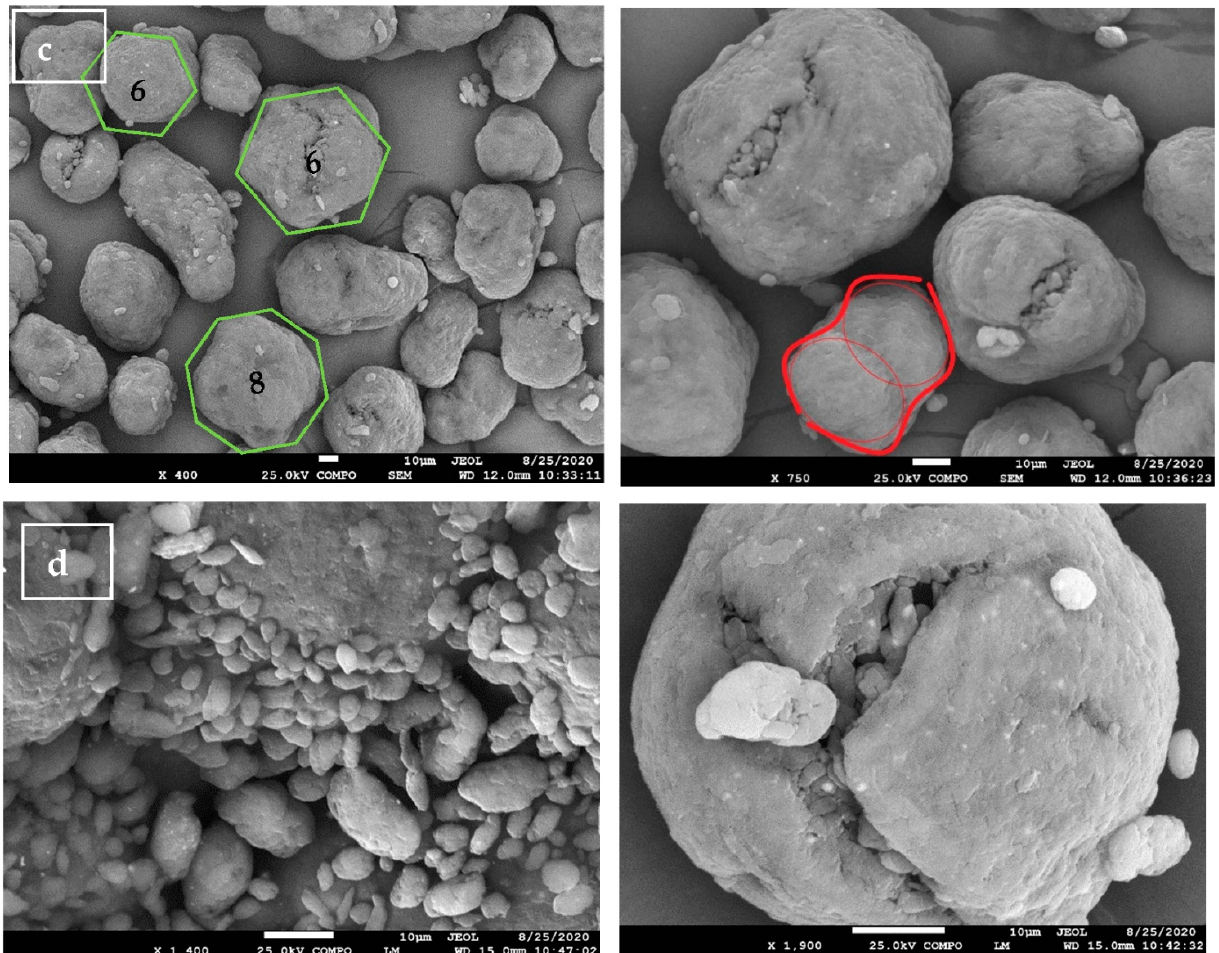
Figure 1. Scanning electron microscopy (SEM) images of experimental samples ( a ) fresh polyamide (PA)-12 and detail of crack; ( b ) scrap PA12 and crack detail with melted bridges on the edge of crack in detail; ( c ) recycled PA12 particle with observed polyhedrons and ( d ) renewed with detail sample. Images captured at 25 kV in COMPO mode. This is a figure. Schemes follow the same formatting.